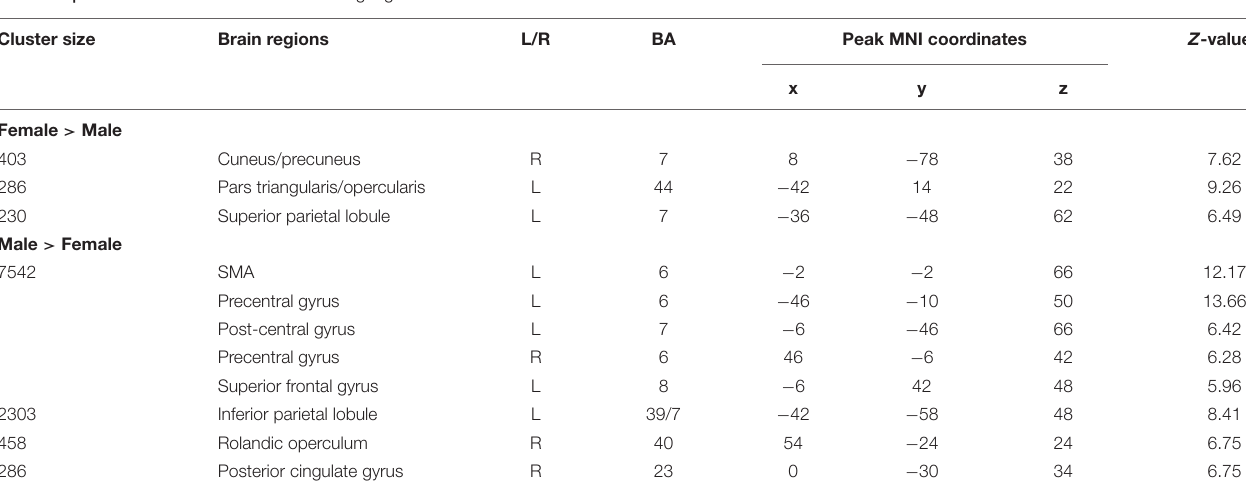
TABLE 2 | Main effect of sex across the two language tasks. Cluster